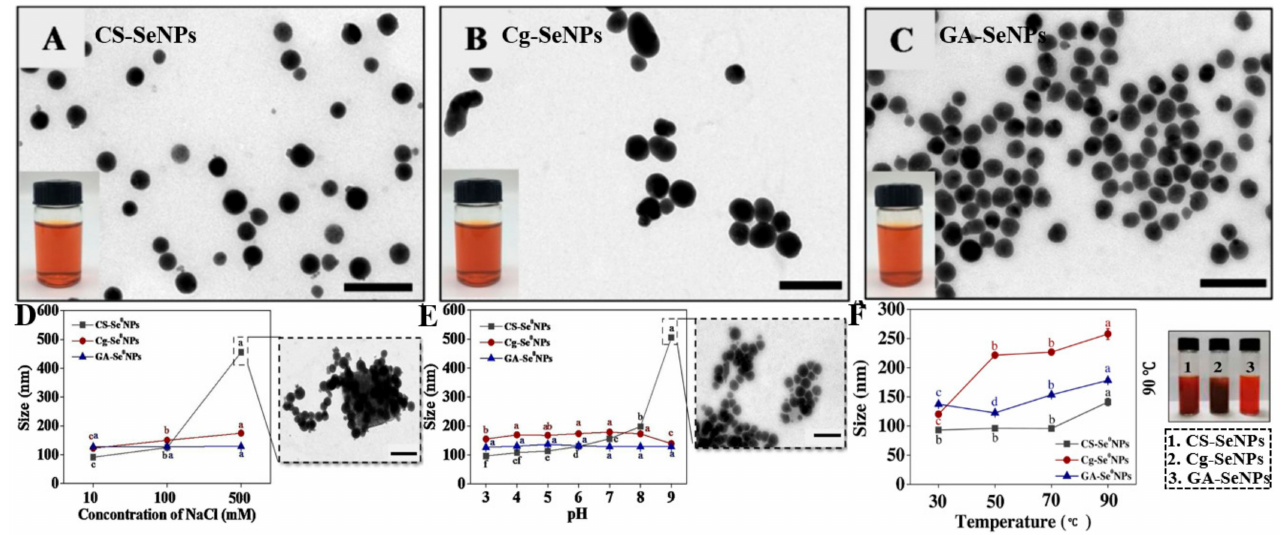
Figure 5. Microstructure and optical photograph of CS-SeNPs ( A ), Cg-SeNPs ( B ), and GA-SeNPs ( C ) investigated by TEM. Effect of different ionic strengths ( D ), pH ( E ), and temperature ( F ) on the stability of CS-SeNPs, Cg-SeNPs, and GA-SeNPs